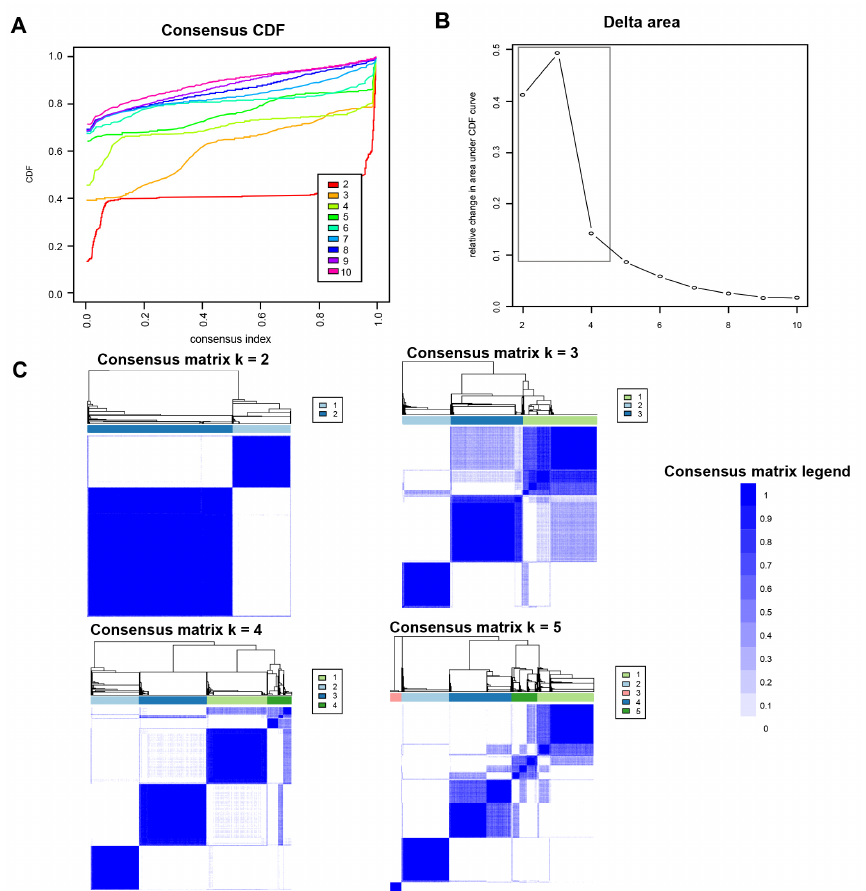
Figure 1. ( A ) CDF plot displaying consensus distributions for each k; ( B ) delta area plot reflecting the relative changes in the area under the CDF curve; ( C ) consensus matrix heat map depicting consensus values on a white to blue color scale of each cluster.